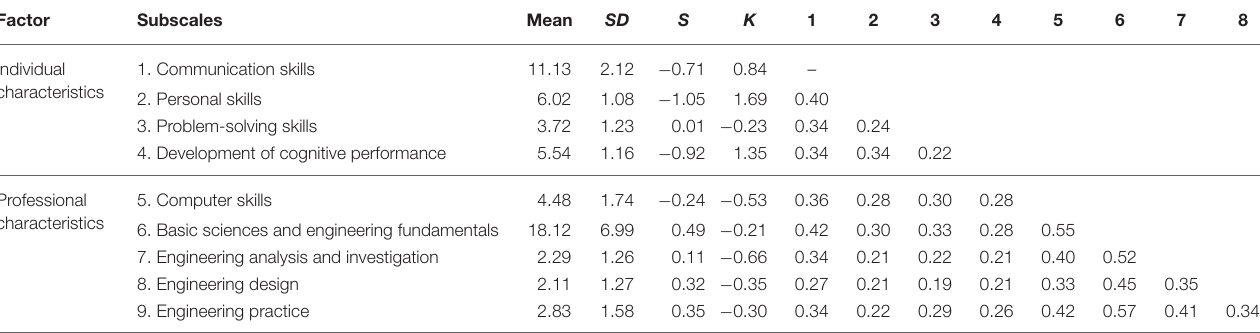
TABLE 1 | Descriptive statistics and inter-correlations among the study variables. Factor Subscales